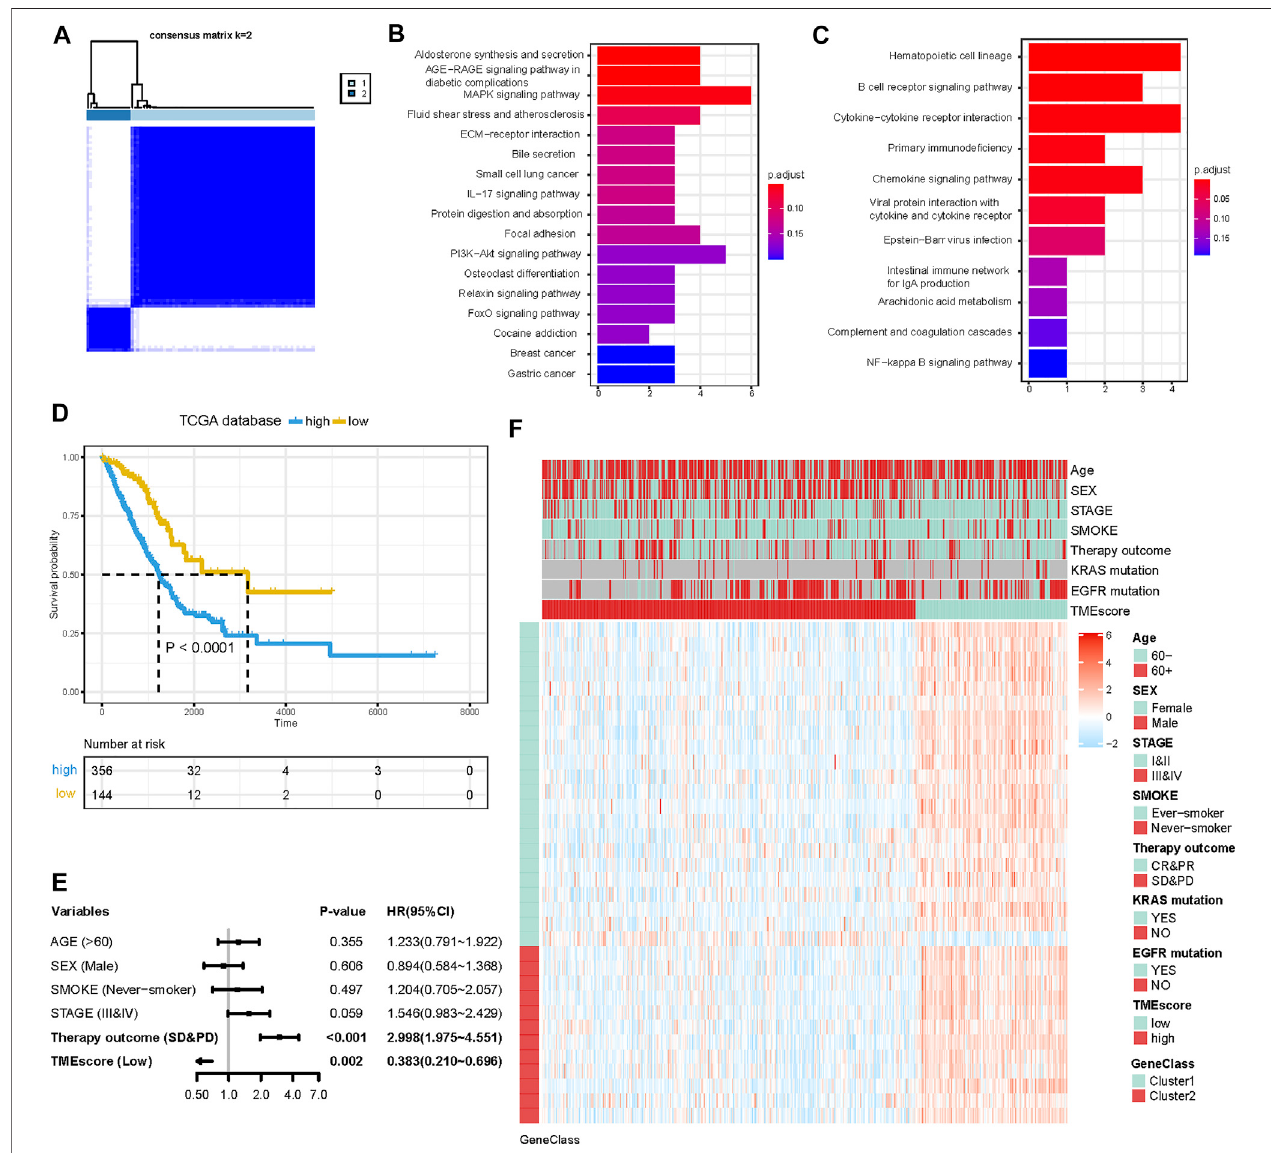
FIGURE 2 | Construction of the TMEscore for LUAD patients. (A) Consensus matrices of differentially expressed genes (DEGs) among TME subtypes. (B and C) KEGG pathway enrichment analysis results in G1 and G2. (D) K-M curve for OS of different TMEscore groups (log-rank test, p < 0.001). (E) Forest plots illustrating the results of multivariate Cox proportional hazards model of clinical feature in TCGA cohort. (F) Heatmap of DEG expression and clinical characteristics. TMEscore, age, sex, stage, smoke, therapy outcome, mutation of KARS, and mutation of EGFR are shown as patient annotations. Gene clusters are shown as gene annotations. Top legend, gray indicates a missing